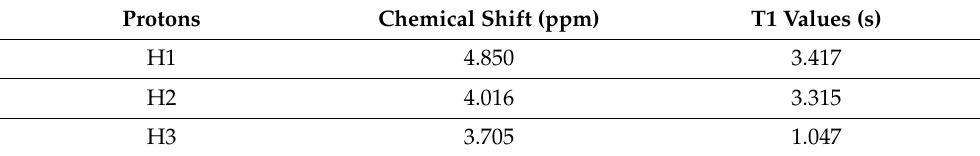
Table 3. T1 measurement of AA in D 2 O (400 MHz, 6.17 mg/mL, D 2 O, pH 3.35, 300 K).